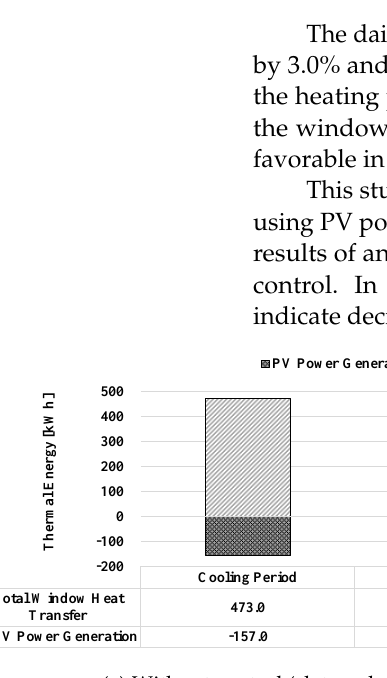
Figure 18. Variation in PV power generation.